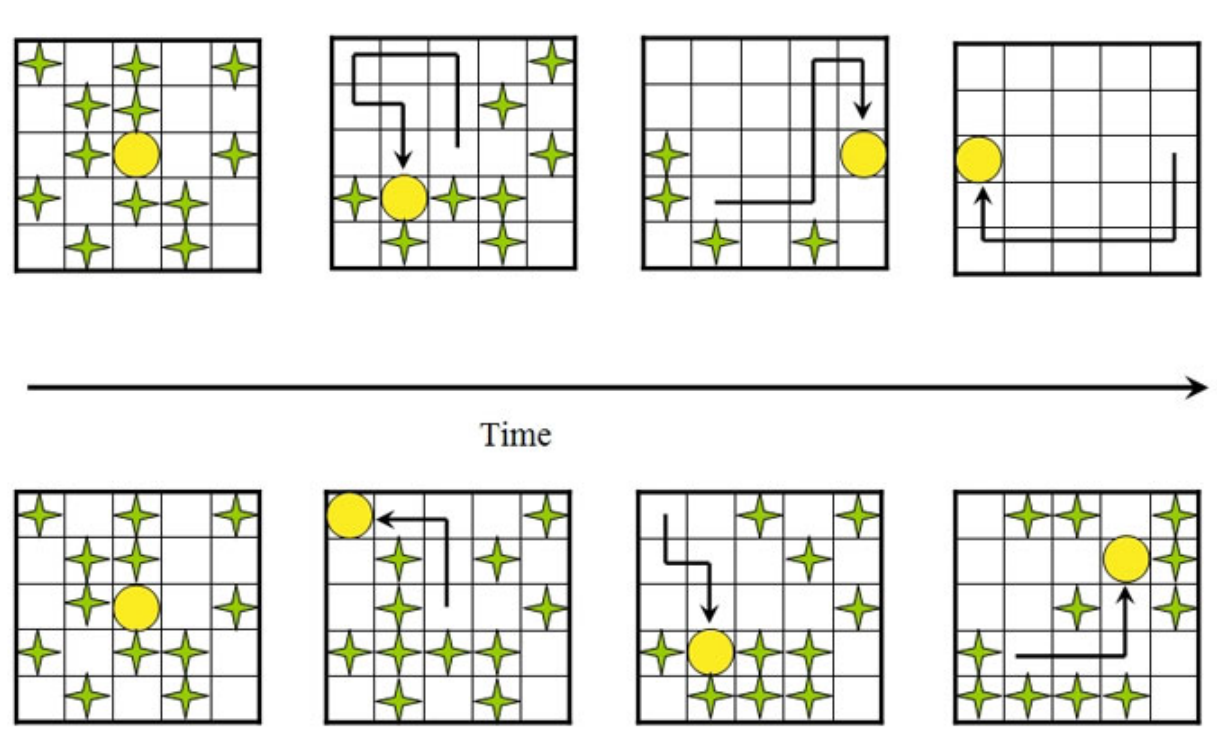
Fig. 2. Four snapshots of two harvesting strategies by two different types of participants in a hypothetical situation of a 5x5 resource, where resource units are depicted by star-shape objects. On the top row in the figure above, the participant moves his/her avatar (circle) eight steps per time period. There is almost no time for regeneration, and a participant following this strategy overharvests the resource by the fourth snapshot. On the bottom row, the participant moves his/her avatar only four steps per time step, and the resource has time to regenerate because enough tokens remain. After four time steps, the resource has not significantly declined, and a participant following this strategy can continue to harvest for many more time